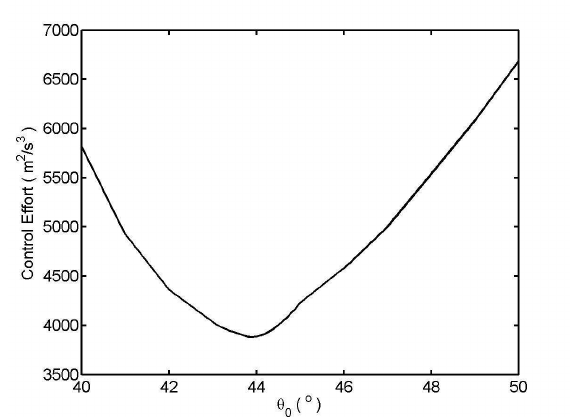
Fig. 5. Integral control effort vs. launch